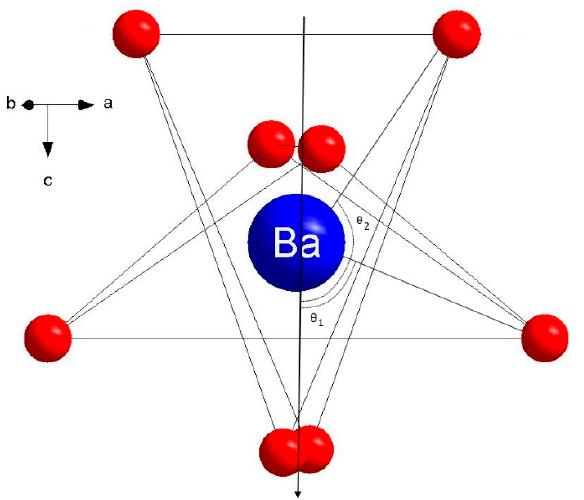
Figure 2. Schematic view of the dodecahedron [BaO 8 ] in BaWO 4 single crystal consisting of two rotated tetrahedrons with marked crystallographic axis Z ( Z || c ) and two polar angles θ i . Therefore, we have two sets of the structural parameters: the distance R H and the i polar angles θ i , and the azimuthal angle s ϕ i , where i = 1, 2 means the first and the second tetrahedron, respectively. These polar and azimuthal angles are angles between the metal– ligand distance R H and Z (fourfold) axis and X axis of the crystal, respectively [25,44]. i ≈ 0.2778 [nm], θ ≈ 69.05 ◦ , ϕ ≈ − 35.16 ◦ , The values for the structural parameters R H 1 1 1 ≈ 0.2738 [nm], θ ≈ 143 ◦ , ϕ ≈ − 24.41 ◦ , were obtained for the Ba 2+ ion and R H 2 2 2